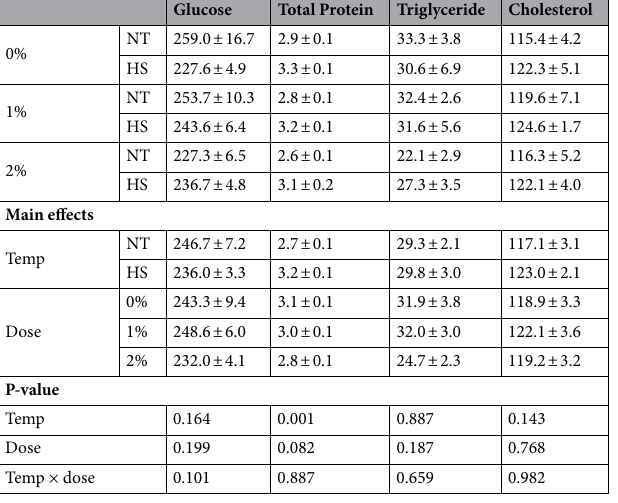
Table 5. Effect of dietary steam-exploded pine particle supplementation on the plasma metabolites of broilers reared under normal or cyclic heat stress conditions. NT thermoneutral temperature, HS heat stress, SEM standard error of the mean. Values are presented as mean with standard error (n = 7).